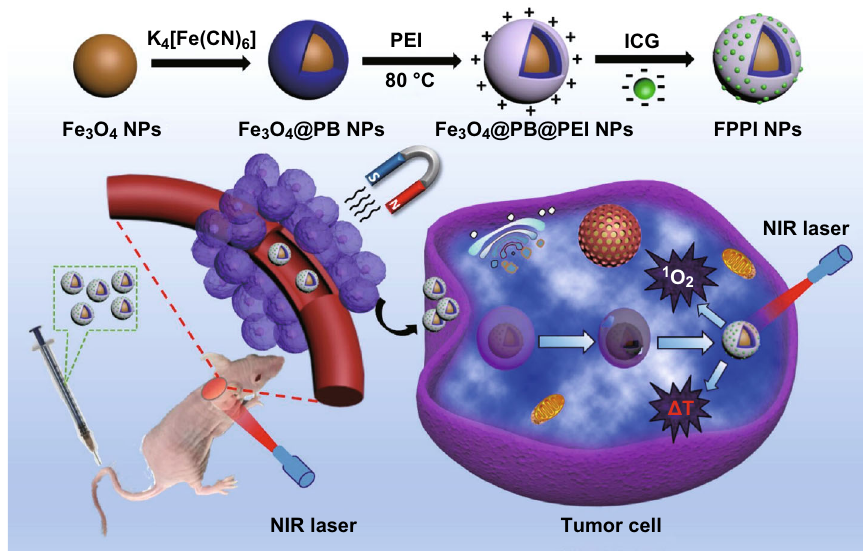
Fig. 1 Schematic of the procedure for FPPI NP synthesis and the combination PDT/PTT cancer treatment. Magnetic FPPI NPs accumulate in the tumor region under a local magnetic field, which produces hyperthermia and toxic ROS activated by NIR light